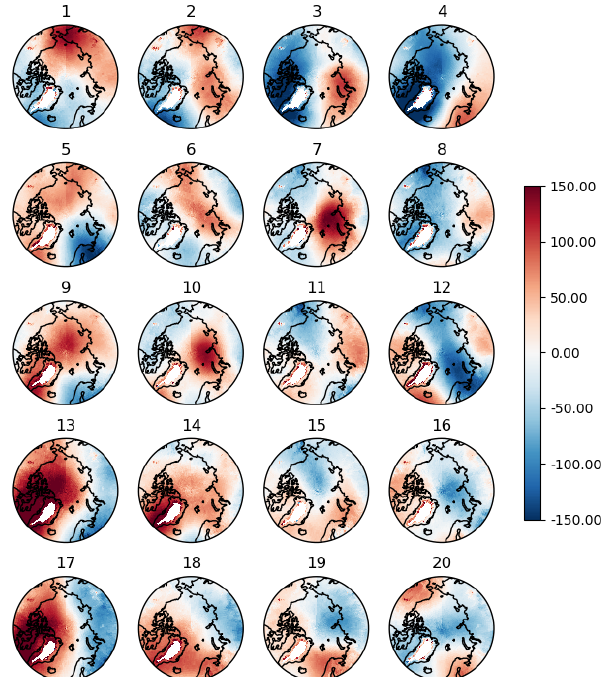
Figure A3. Geopotential height anomalies (m) at 500hPa based on AIRS data for the 20 circulation types.